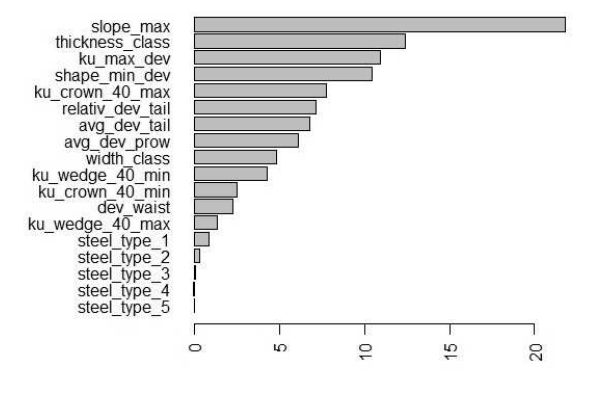
Figure 4: The importance of each variable in the model.